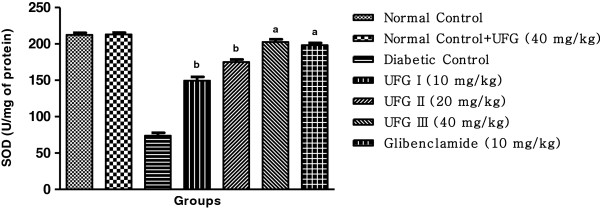
Effect of umbelliferone β-D-galactopyranoside on level of SOD (Superoxide dismutase) cholesterol at different concentrations on STZ induced diabetic rats, compared to diabetic control group rats; values are mean ± SEM; n = 6;
c
P < 0.05;
b
P < 0.01;
a
P < 0.001; P > 0.05 is considered as non-significant (ns).